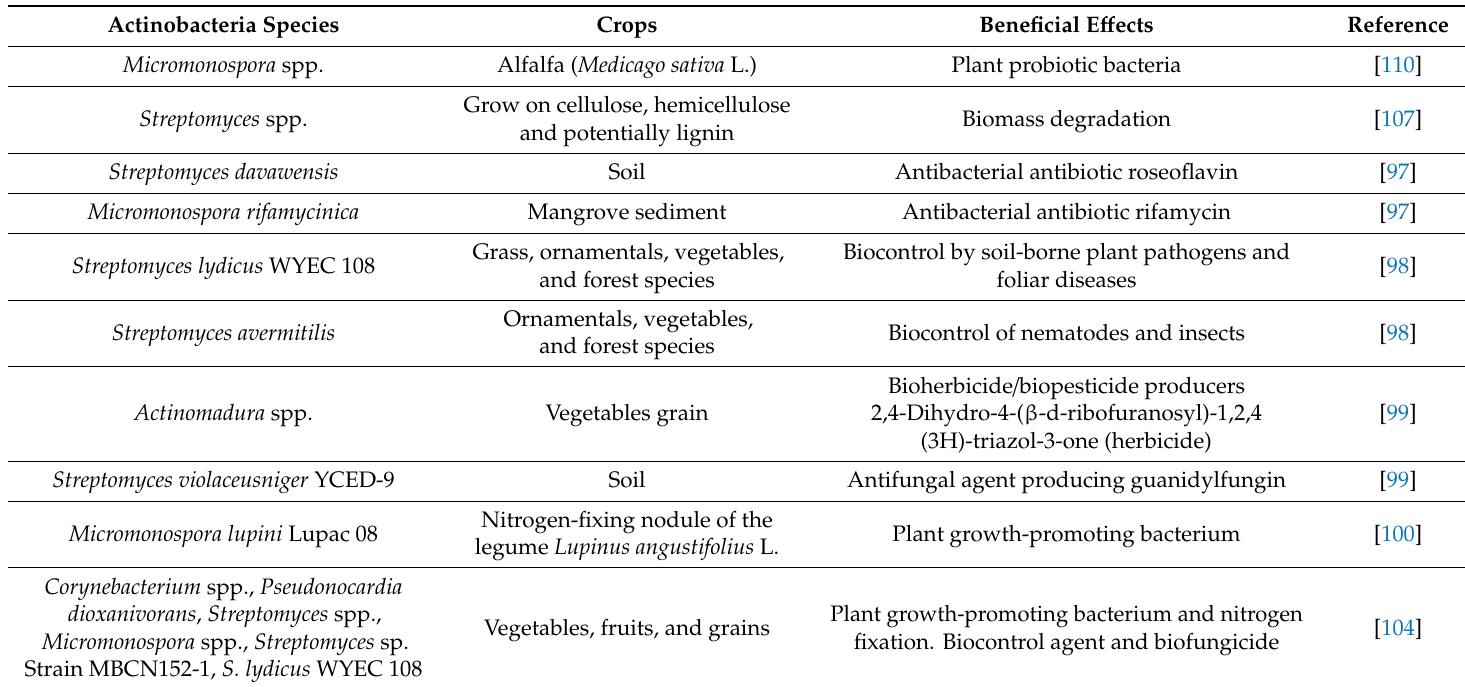
Table 3. Beneficial e ff ects of Actinobacteria in agroforestry